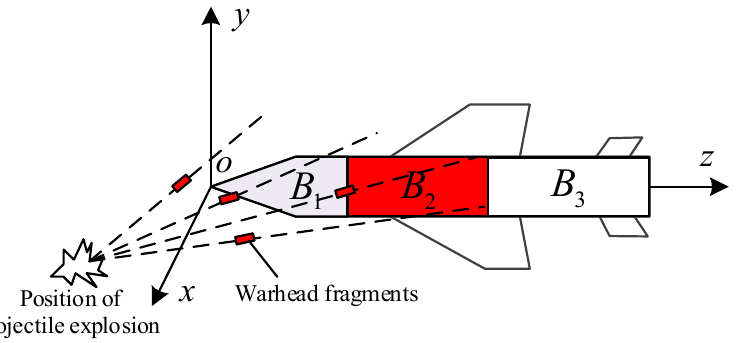
150, 200, 250, and 300, respectively. Figure 3 shows the intersection of the projectile and target segmentation area. The target is considered relatively stationary, and the distance between the projectile explosion position and the target is relatively short, so the decay of the warhead fragment velocity is not considered in this paper.